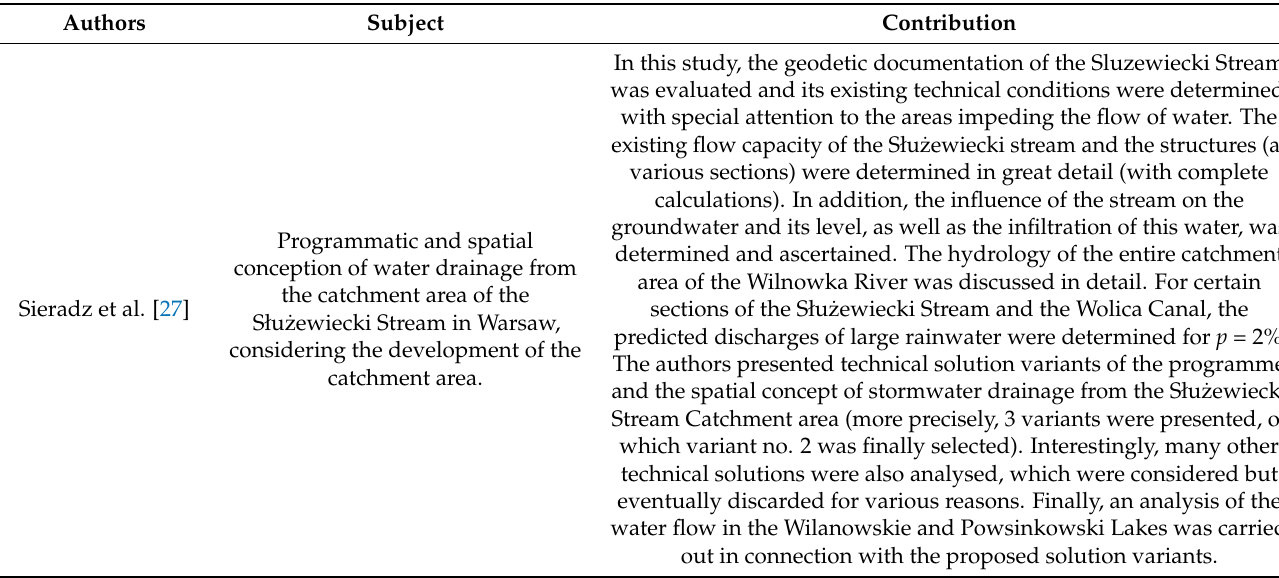
Table A1. Scientific approach—various fragments (and water installations) of the Warsaw hydrologi- cal